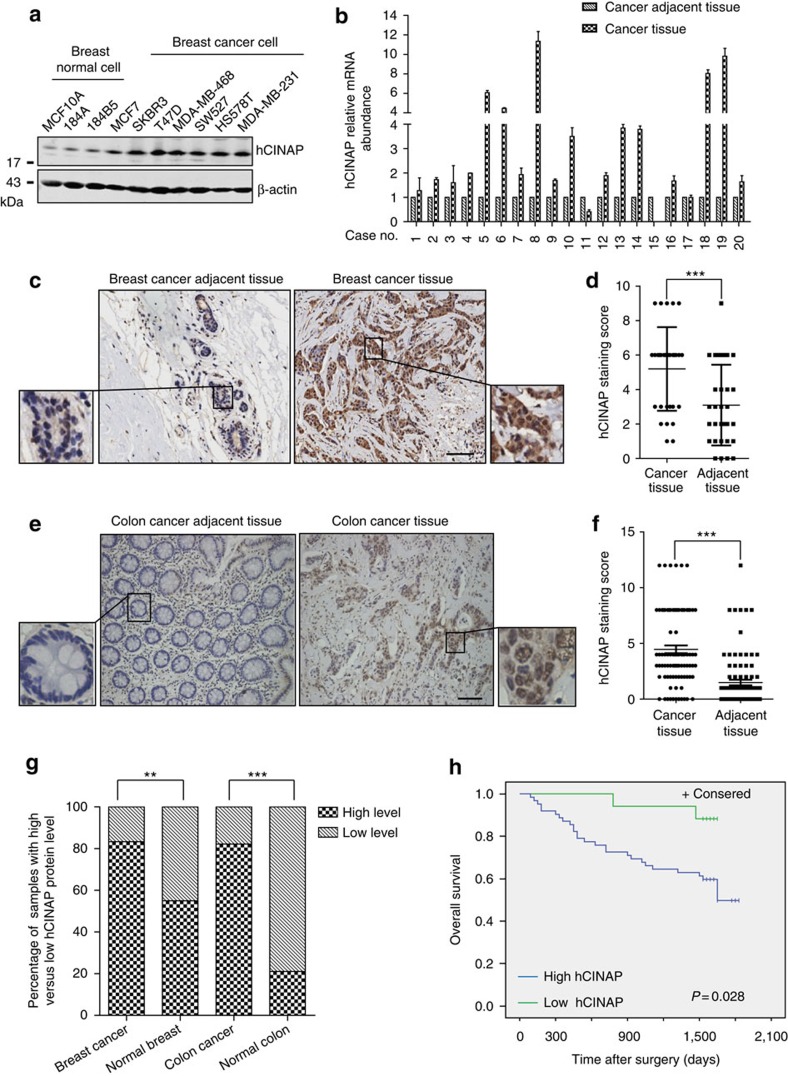
hCINAP is highly expressed in human cancers and correlated with a worse prognosis.(a) Expression of hCINAP in a panel of human breast cell lines was detected by western blotting. (b) Quantitative reverse transcriptase–PCR was used to detect the relative mRNA level of hCINAP in human breast tissue, which was compared with that of adjacent paired cancer tissue. Results are presented as mean±s.d. (c,e) IHC was performed using anti-hCINAP antibodies to detect hCINAP expression with human breast cancer and colorectal adenocarcinoma cancer tissue arrays with diaminobenzidine (DAB) staining. Scale bars, 50 μm. (d,f) Plots of the scores for the cytoplasmic hCINAP in each pair of tissue samples. Statistical significance was determined by the Mann–Whitney U-test. (g) The stacked bars indicate the percentages of samples with high and low hCINAP expression levels relative to the total number of samples in each section. Data were analysed using Pearson's χ2-test. **P<0.01 and ***P<0.001. (h) Kaplan–Meier curve of the 5-year overall survival of 90 patients with colorectal adenocarcinoma. Patients were divided into ‘high hCINAP' group (the score of hCINAP expression in the cancer tissue >2) and ‘low expression' group (the score of hCINAP expression in the cancer tissue ≤2). The difference of the overall survival between these two groups was determined using a log-rank test.